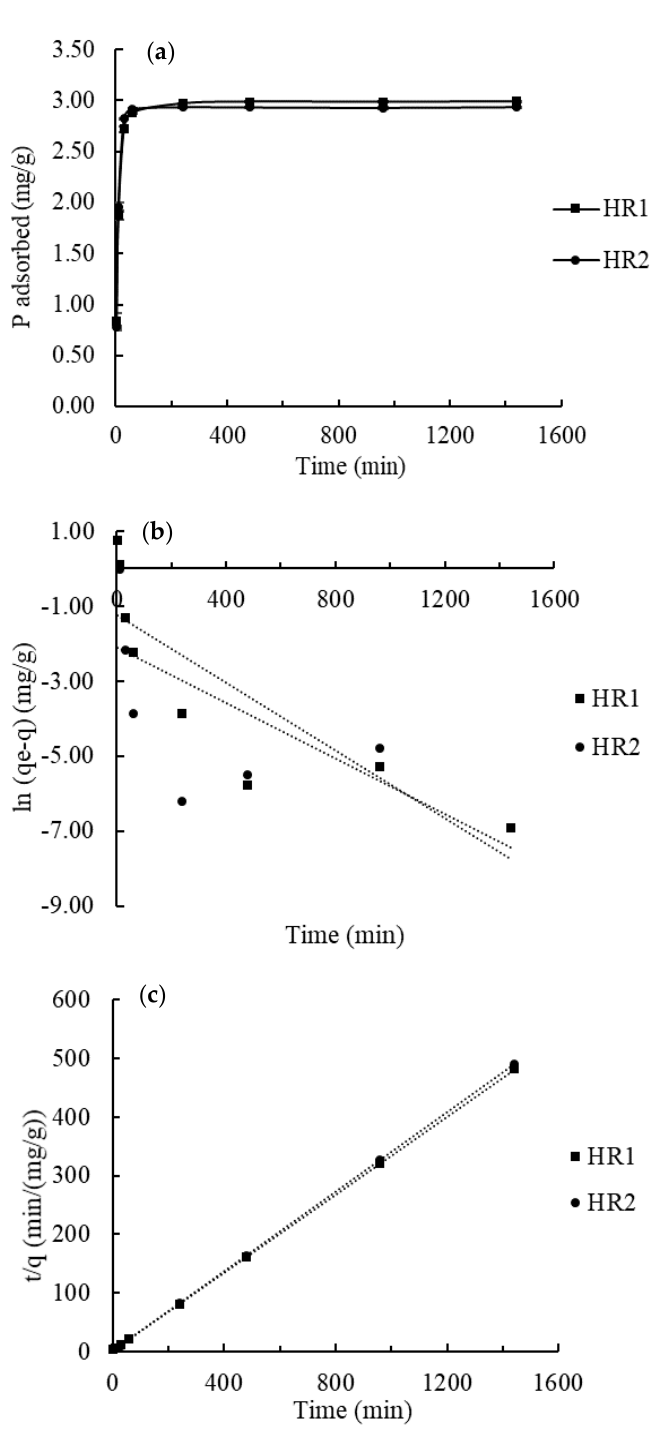
Figure 4. ( a ) Phosphate adsorption kinetics in the hybrid resins. ( b , c ) Show the linear fitting in the Pseudo-first-order model and the Pseudo-second-order model, respectively. Overall, hybrid anion exchange resin is highly reactive for dissolved P. This property makes them ideal adsorbents for the passive detection